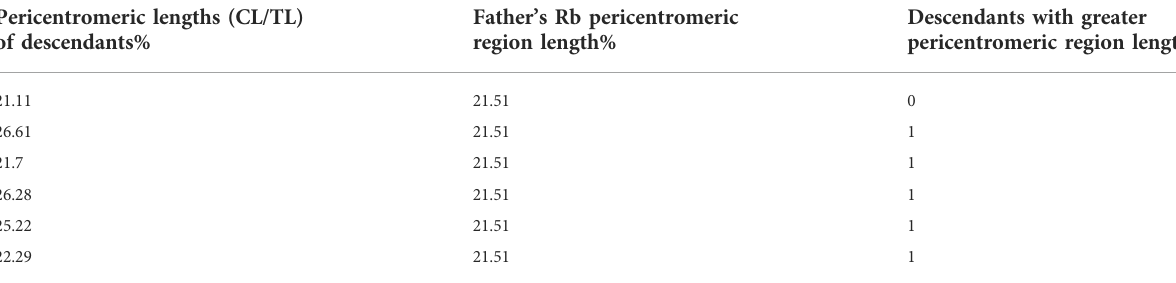
TABLE5In5ofthe6descendants,the lengthofthepericentromeric regionwas veri fi edtobegreaterthantheaveragelengthofthepericentromeric regions of the Rb chromosomes of the father. The ratio 5/6 is greater than 0.5 (inheritance by chance) p = 0.0512. Pericentromeric lengths (CL/TL) of